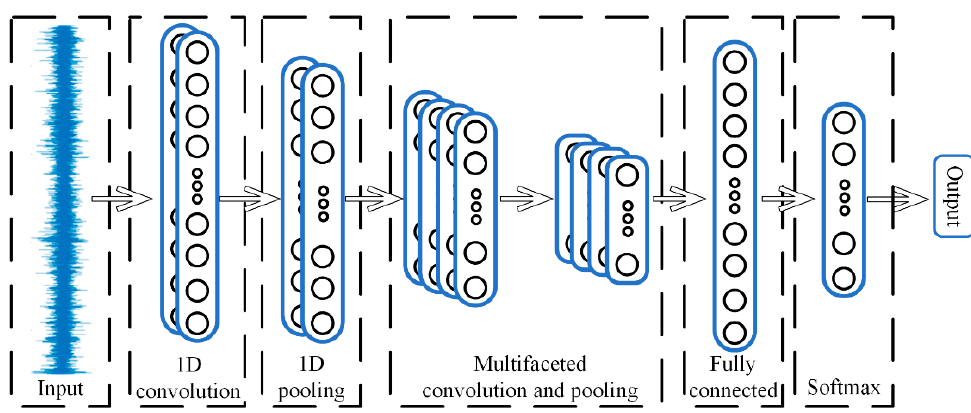
Figure 5. One-dimension convolutional neural network.